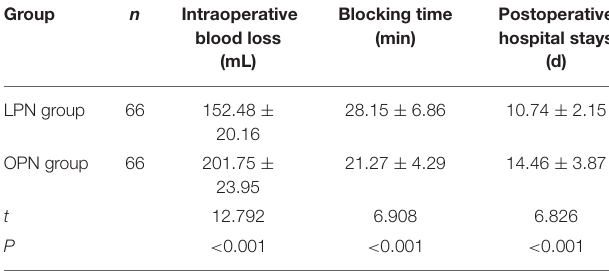
TABLE 5 | Comparison of perioperative indicators ( x ±